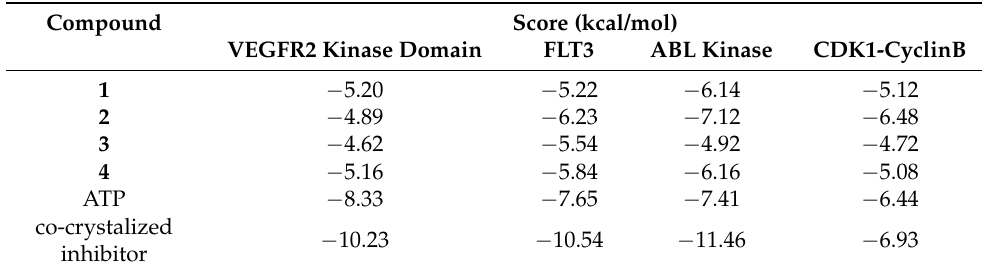
Table 1. Docking scores for compounds 1 – 4 .